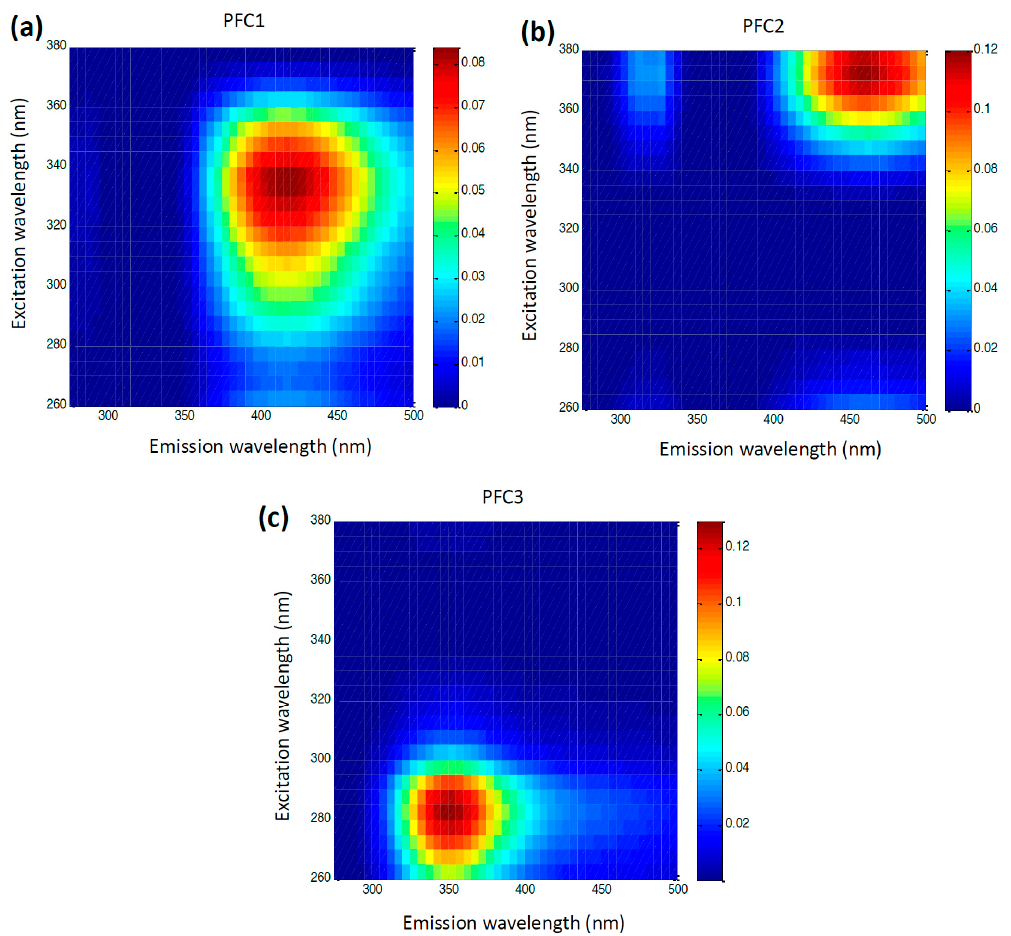
Figure 3. EEM heatmaps for the first ( a ) and the second ( b ) and the third ( c ) PARAFAC component corresponding to the proteins and phenolic compounds in honey samples, respectfully. Intensity scale is in arbitrary units.